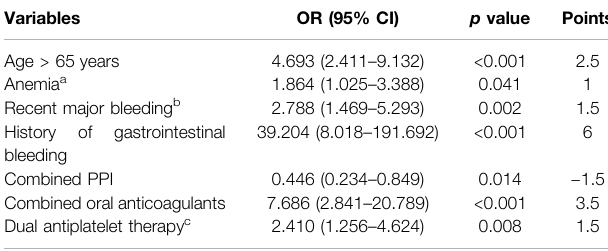
TABLE 2 | Gastrointestinal bleeding risk with a univariate analysis.